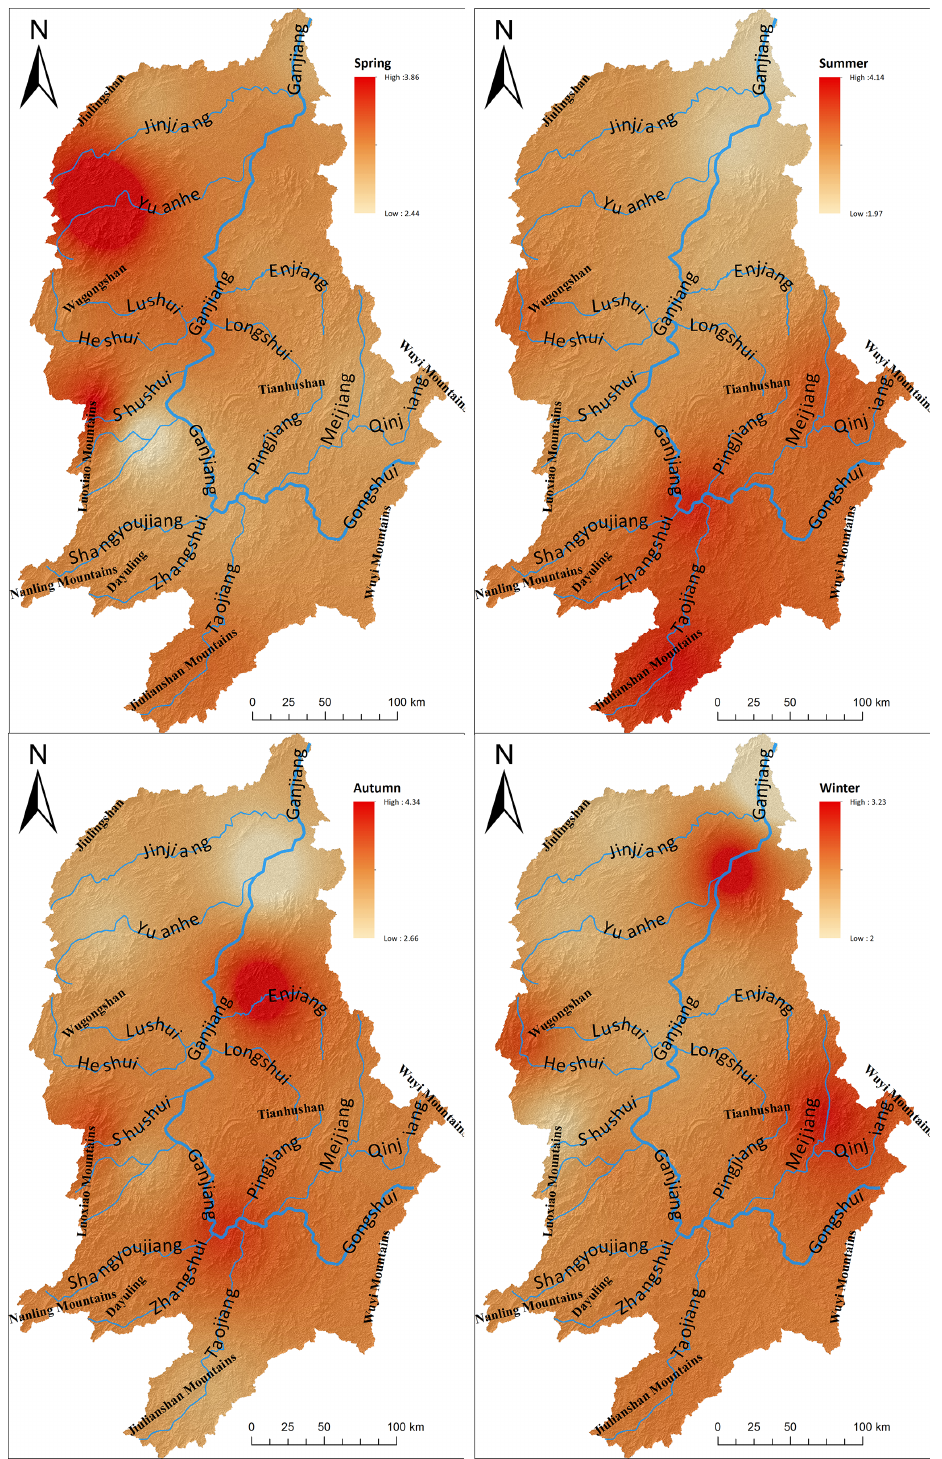
Figure 6. Extreme precipitation risk under Scenario 2 in spring, summer, autumn and winter in the Ganjiang River basin. The colors range from light orange to red, indicating the increasing risk from low to high. The numbers are the annual average of the estimated extreme precipitation